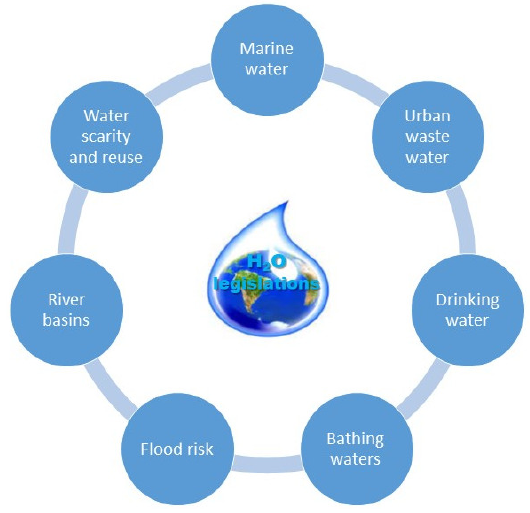
Figure 1. Legislations having “water” as